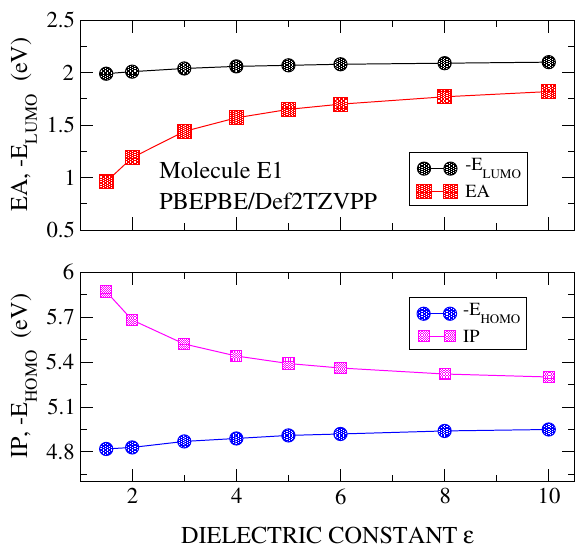
Figure 4. Calculated values of IP and E HOMO ( lower panel ) and EA and E LUMO ( upper panel ) for molecule E1. Calculations were carried out with PBEPBE/Def2TZVPP method and using PCM with a dielectric constant ε varying in the range 1–10. Table 1. Ionization potential (IP) and electron affinity (EA) both in eV, of three electron-acceptor (E1, E2 and E3) and two hole-acceptors (H1 and H2) in amorphous organic materials (AOM) calculated using DFT with four functional/basis-set combinations, and polarizable continuum medium (PCM). The reported dielectric constants ε (used also in the calculations of IP and EA) are those at which IP = − E − E HOMO , or EA = LUMO (see Figures 2 and